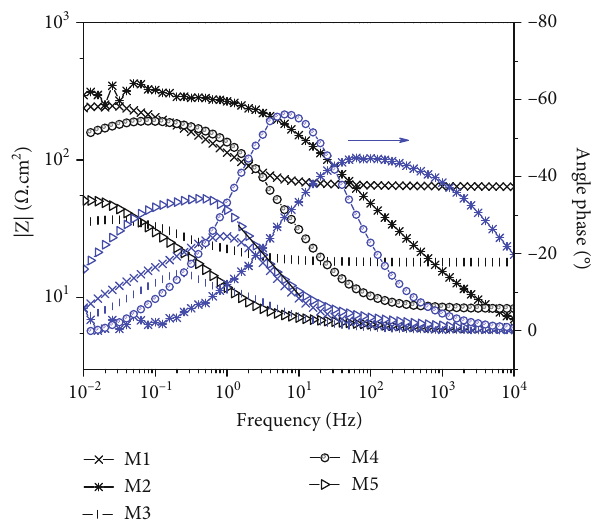
Figure 2: Modulus impedance and angle for aluminum-based alloy doped with Mn and Co as cast, immersed in 3M KOH.